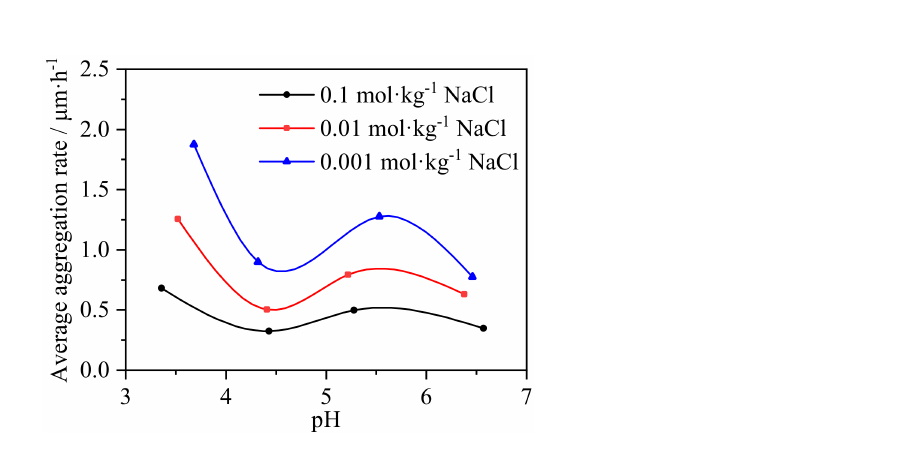
Figure 5. Average aggregation rate of the IREO colloids after salinity and pH value